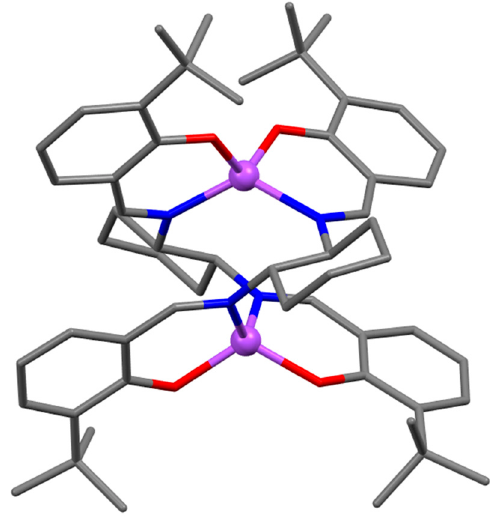
Figure 7. Crystal structure of P -( S , S )-9. Adapted from Ref. [37].